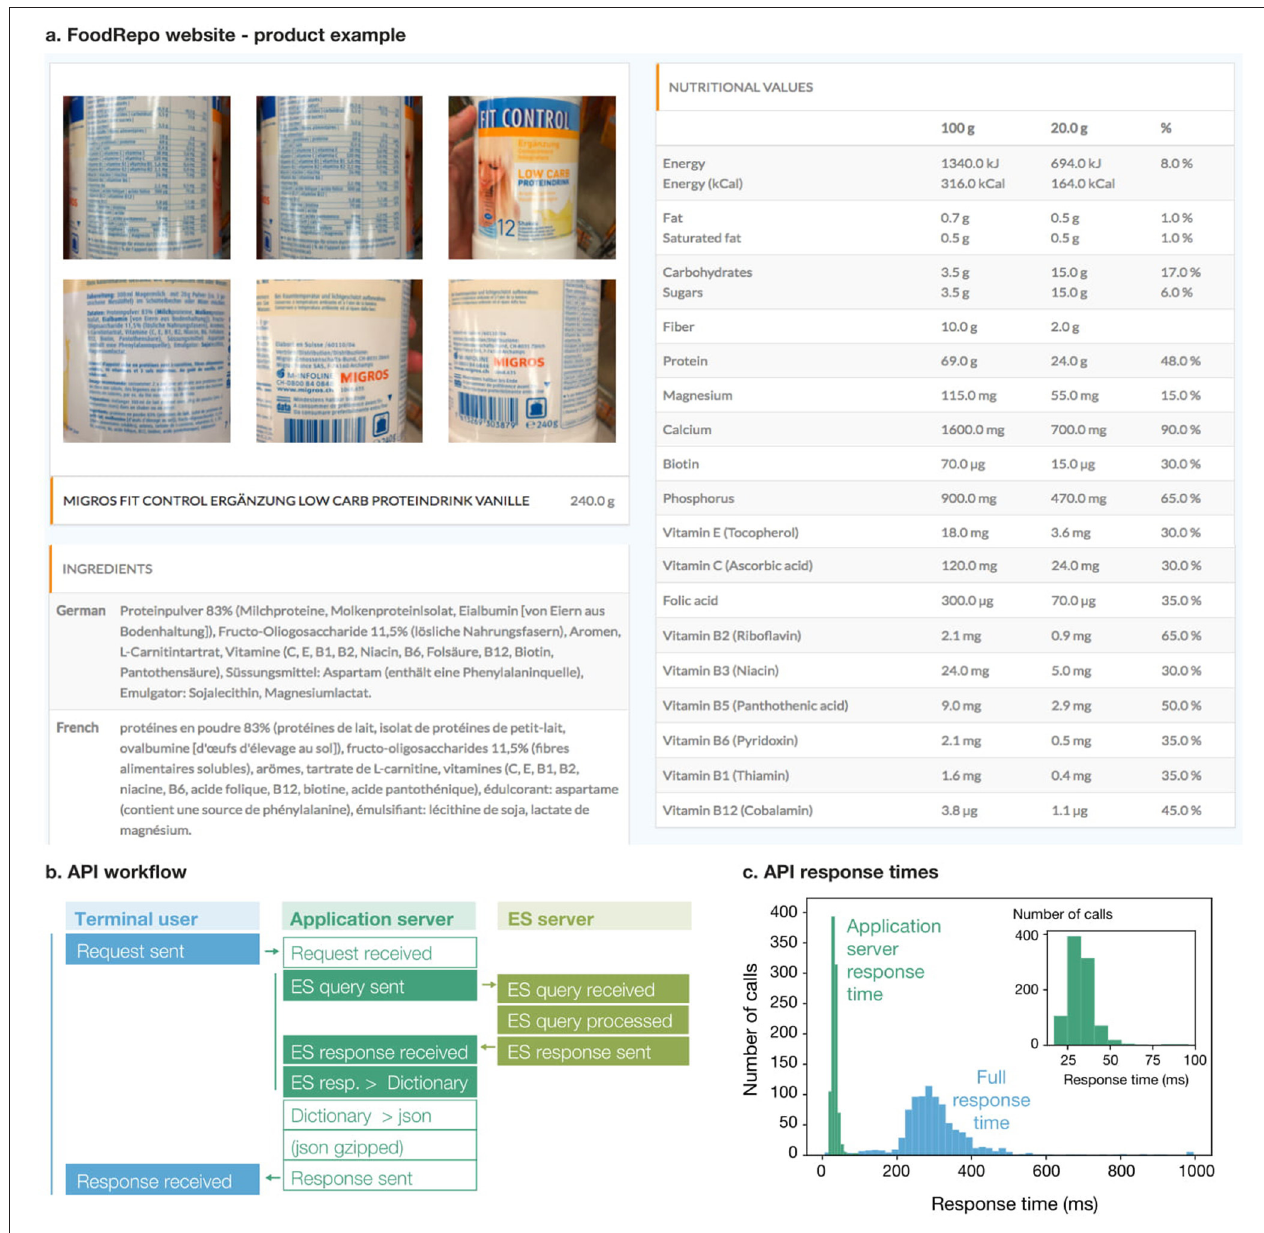
FIGURE 1 | (A) Screenshot from the webpage of a product on the FoodRepo website. (B) Schematic representation of the pipeline behind our API. When a user or an application (left column) sends a call to the API, the request is handled by the server that hosts the API (middle column). This sends then a query to the server which hosts the FoodRepo database (right column), where the query is handled by the Elastic Search engine. The data is returned to the API server which performs final formatting before giving it back to the user or the application. (C) Distribution of API response times, color-coded according to different sections of the back-end pipeline, as shown in (B) . In green (main plot and inset) the response-times of the Elastic Search server to the application server; in blue the full time needed for a user to have the data after a call to our